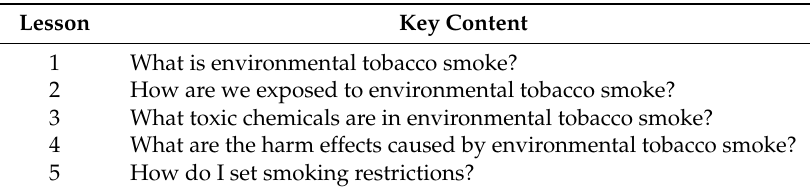
Table 2. “Set the Rules”